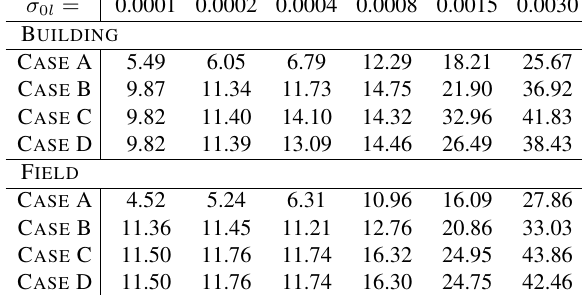
Table 1. The loss in accuracy ∆ F C in percent of estimated ASE pose parameters induced by the individual approximations of C ASE A-D at different noise levels σ 0 l in